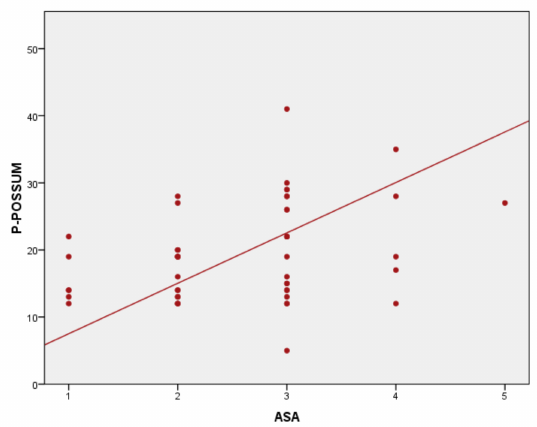
Figure 1. American Society of Anesthesiologists (ASA) score–Physiological and Operative Severity Score for the enumeration of Mortality and morbidity (P-POSSUM) score